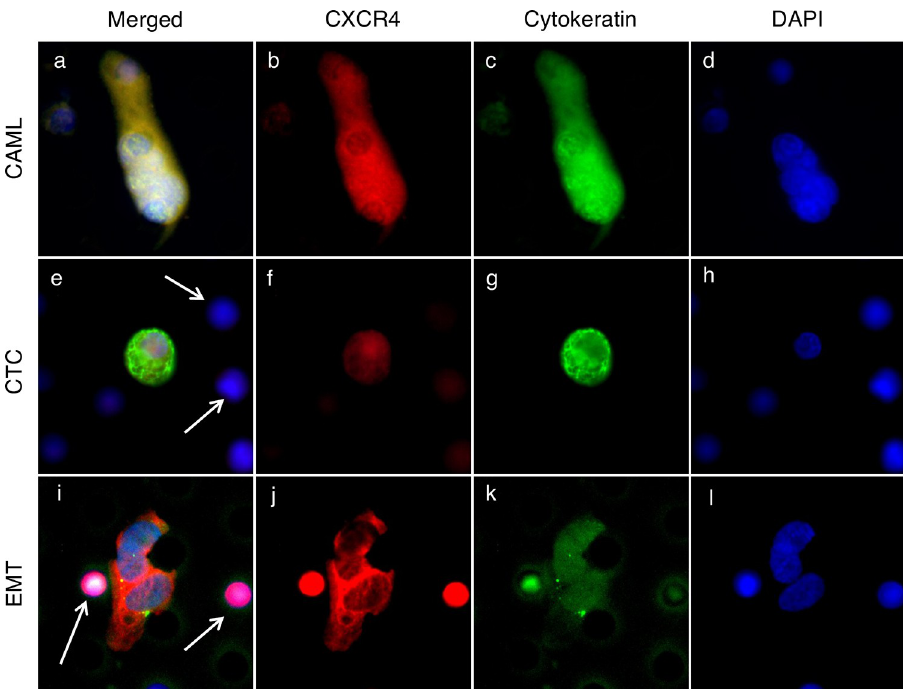
Fig 1. Images of CAML, CTC, EMTs, and white blood cells. a-d. CAMLs are enlarged cells with a polyploid nucleus (blue) and diffuse Cytokeratin (green), and can be CXCR4 positive (red). e-h. CTCs are cells with a nuclei (blue) and filamented Cytokeratin (green), and can be CXCR4 positive. i-l. This is a cluster of EMTs. EMTs are cells typically presenting with smooth, oval shaped nuclei (blue) and weak Cytokeratin (green), and can be CXCR4 positive. White arrows highlight normal white blood cells. Boxes = 60 μ